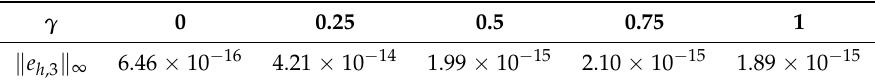
Table 1. Example 1: The infinity norm of the approximation error.